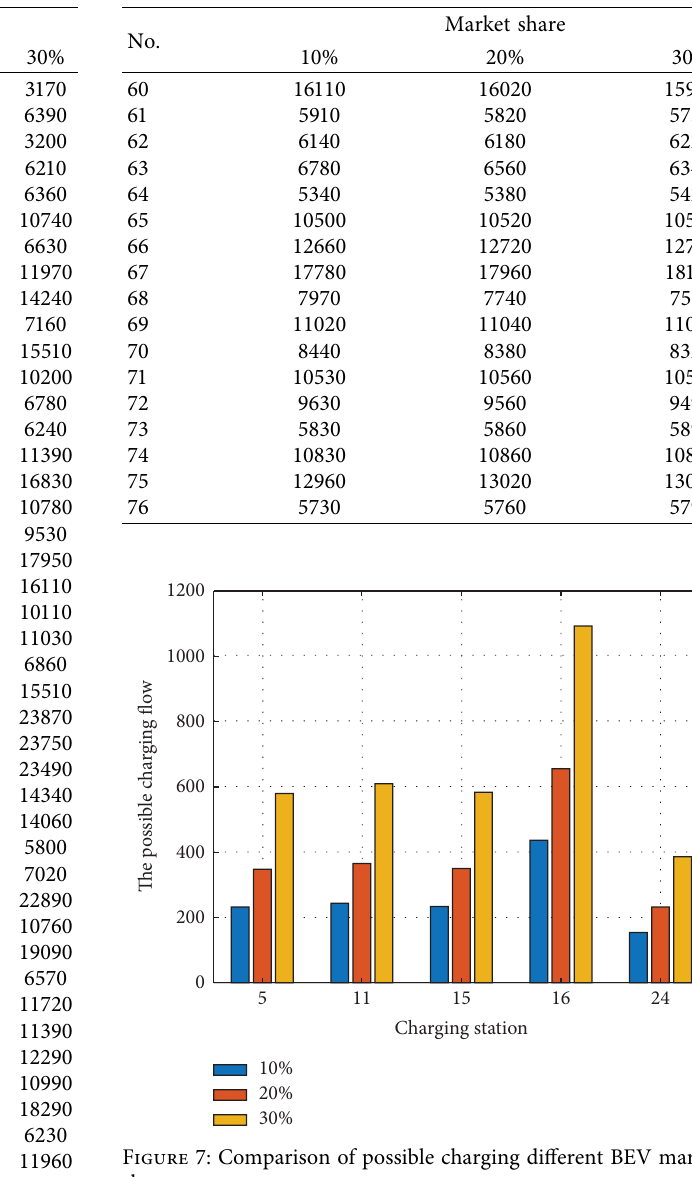
Table 4: Generalized link fow (veh/h).